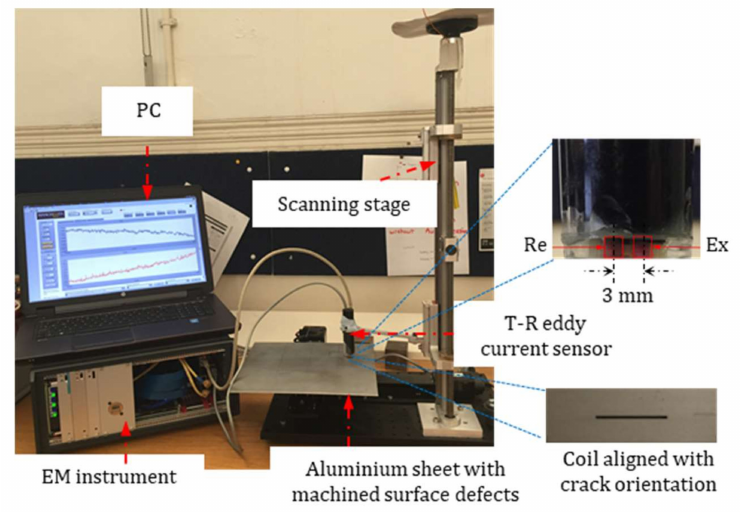
Figure 3. Experimental setup for electromagnetic imaging of surface cracks using T-R eddy current sensor.